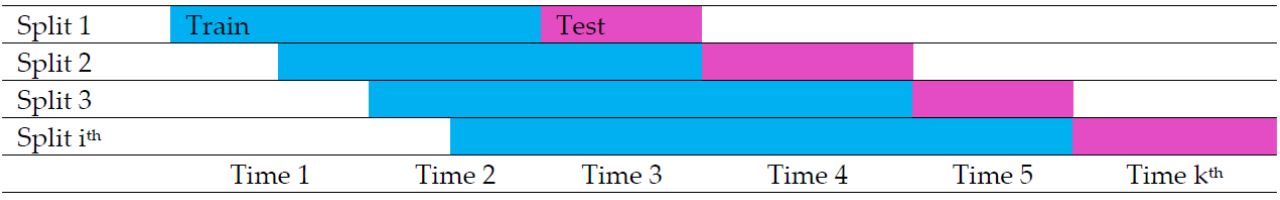
Figure 5. Graphic presentation of sliding window time series cross-validation.